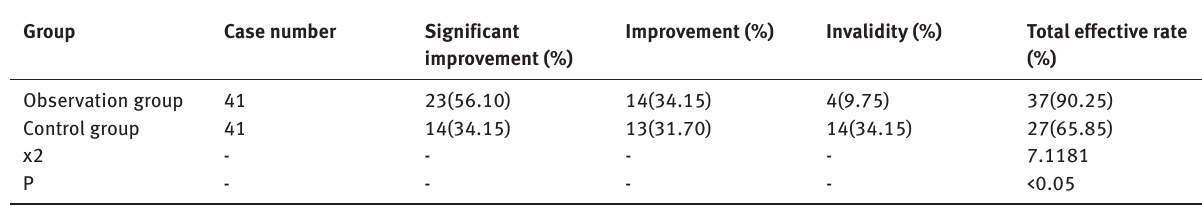
Table 1: Comparison of total effective rate between two groups